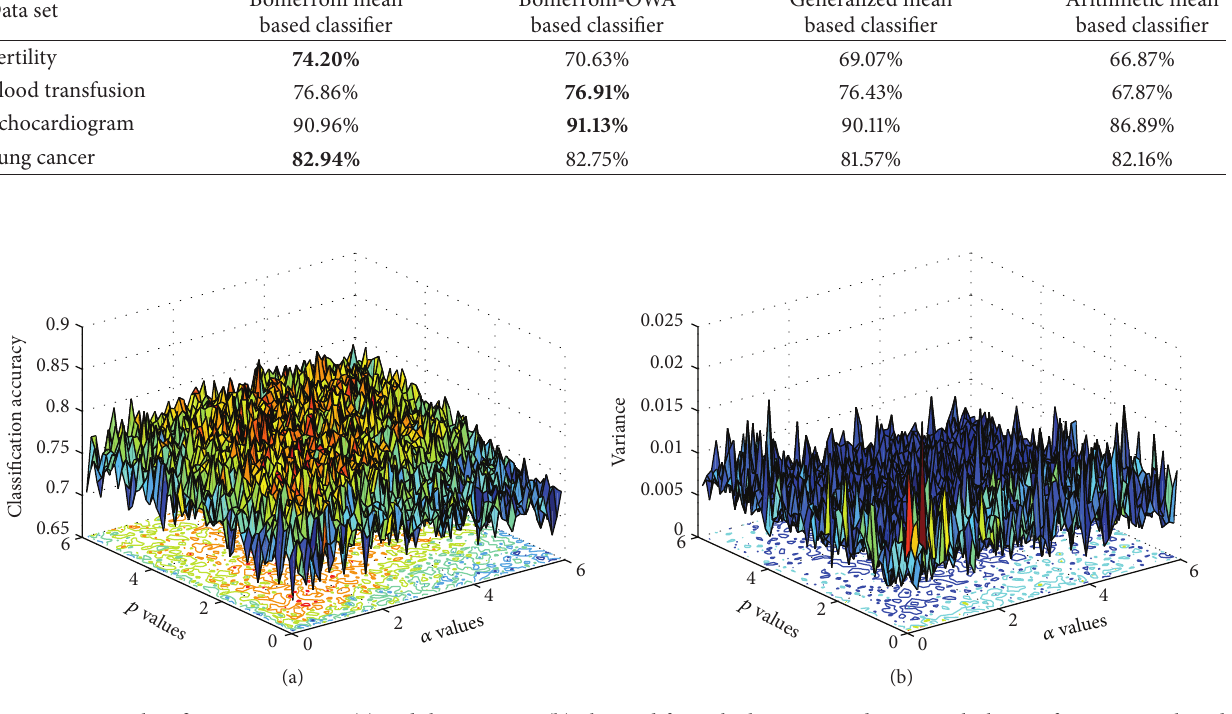
Figure 4: Mean classification accuracies (a) and the variances (b) obtained from the lung cancer data set with the Bonferroni mean based similarity classifier, when 𝑞 = 3